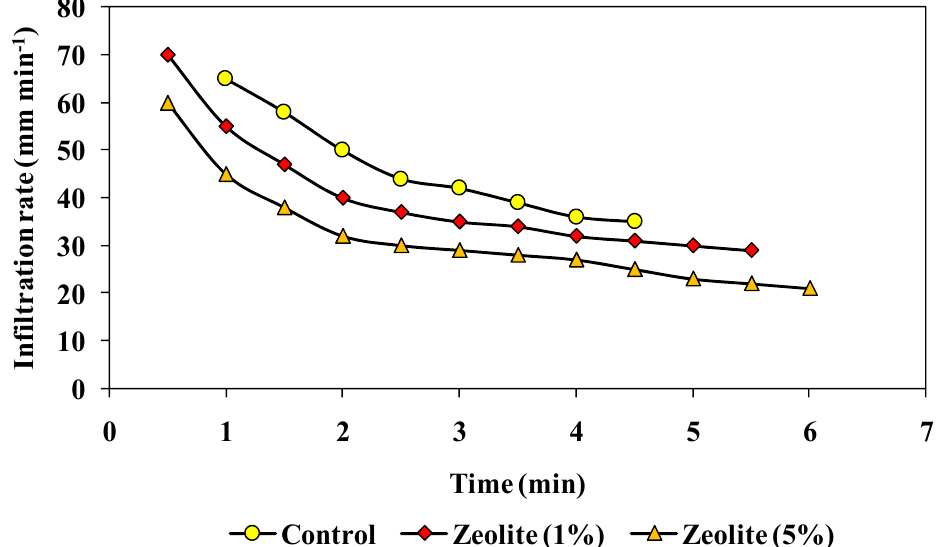
Figure 6. Soil Infiltration Rate as Influenced by Different Rates of Zeolite Application. Modified from Al-Busaidi et al. [16].